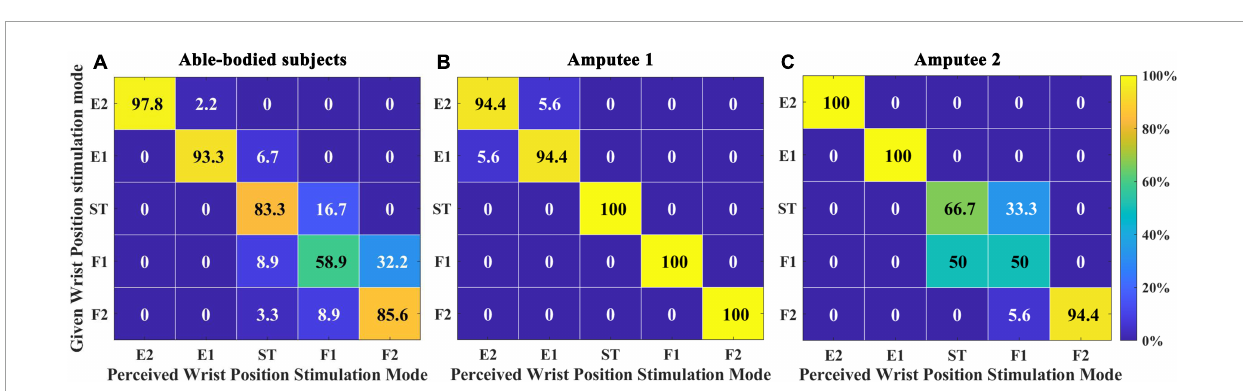
FIGURE6 Confusion matrix quantifying the percentage of instances when comparing the perceived wrist position stimulation mode with a given stimulation mode in Exp 1. (A) Five able-bodied subjects, (B) amputee 1, and (C) amputee 2. The number in the each rectangle represents the SR (success rate), and the shade of the color represents the level of